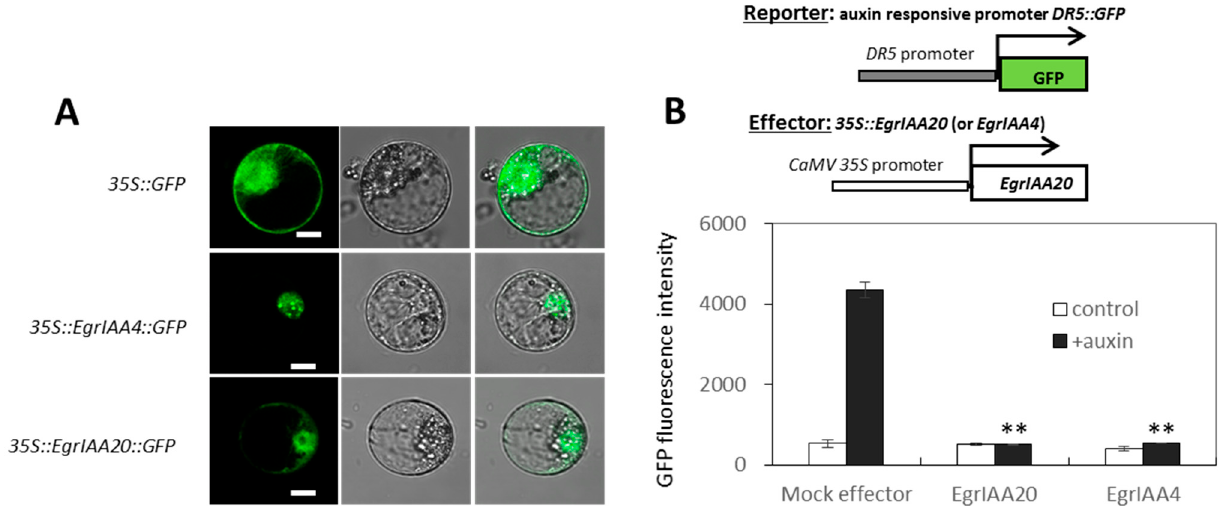
Figure 3. Subcellular localization and repressor activity of auxin response of EgrIAA20 protein on a synthetic DR5 promotor. ( A ) Subcellular localization of EgrIAA20 -GFP fusion protein in BY-2 tobacco protoplasts. The merged images of green fluorescence (left panel) and the corresponding bright-field image (middle panels) are shown in the right panels. Canonical Aux/IAA member EgrIAA4-GFP serves as a positive control. Scale bar = 10 µm. ( B ) Transcriptional repression of auxin response by EgrIAA20 protein on a synthetic DR5 promotor. Effector and reporter constructs were co-expressed in tobacco protoplasts in the presence or absence of a synthetic auxin (50 µM 2,4-D). A mock effector construct (empty vector) was used as negative control, and EgrIAA4 construct was used as positive control. Three independent experiments were performed, and similar results were obtained. In each experiment, protoplast transformations were performed in independent biological triplicates. The figure indicates the data from one experiment. Error bars represent SE of mean fluorescence. Significant statistical differences (Student’s t -test, n > 400, p < 0.01) from the control are marked with **. The schemes of the reporter and effector constructs are illustrated on the top of the figure.